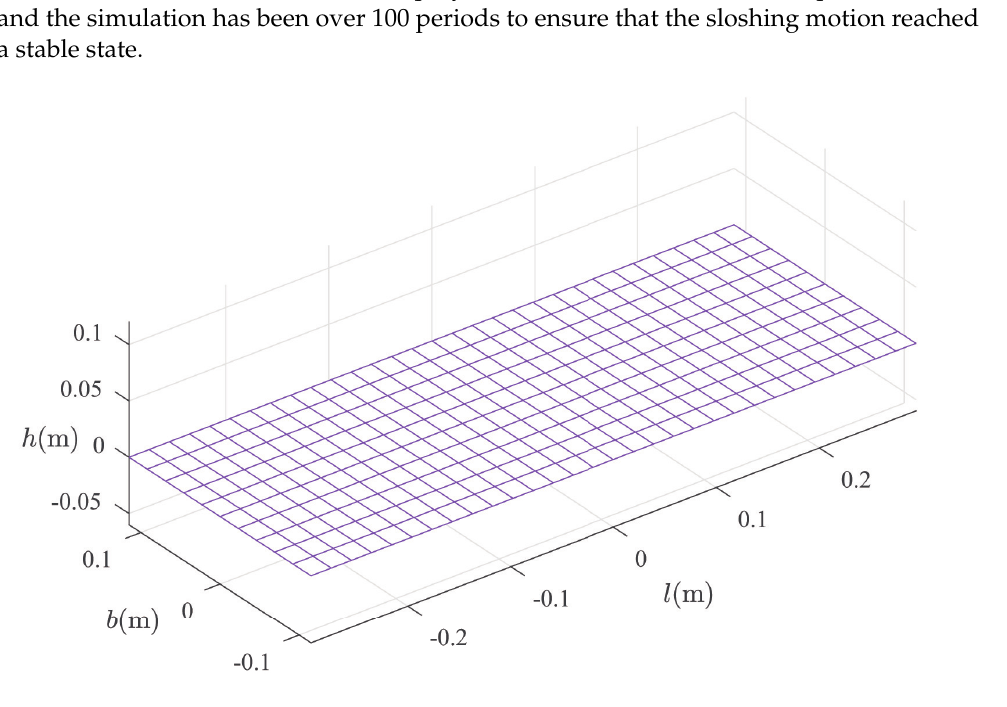
Figure 2. The uniform grid on the free surface in the three − dimensional